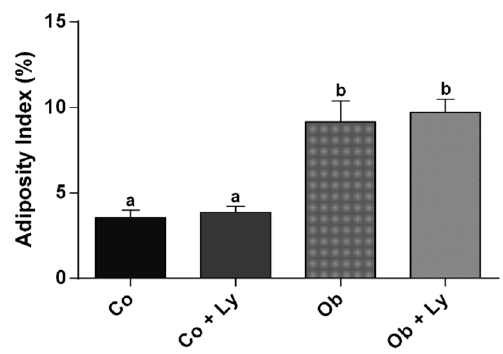
Figure 1. Determination of the presence of obesity: Adiposity index (%). Co: Control group; Co + Ly: control group supplemented with lycopene; Ob: Obese group; Ob + Ly: Hypercaloric group supplemented with lycopene. Data expressed in mean ± standard deviation. Comparison by two-way ANOVA with Holm-Sidak post-hoc test. Different letters correspond to the significant statistical difference ( p <0.05); n = 6 animals/group.